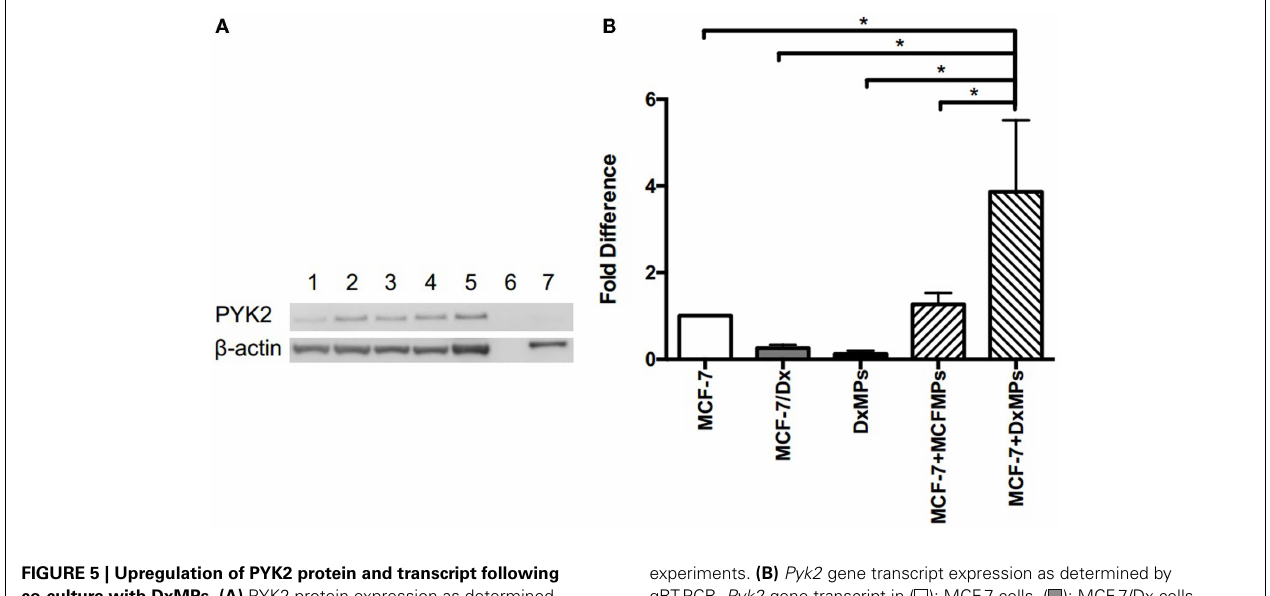
FIGURE 5 | Upregulation of PYK2 protein and transcript following co-culture with DxMPs . (A) PYK2 protein expression as determined byWestern blotting.Total lysates of MCF-7 cells (lane 1), MCF-7 cells co-cultured with DxMPs (lanes 2, 3, and 4), MCF-7/Dx cells (lane 5), and DxMPs (lane 7) were examined for PYK2 expression byWestern blotting using the PYK2 (clone 5E2) mAb. β -actin was used as an internal control. Data was representative of at least three independent